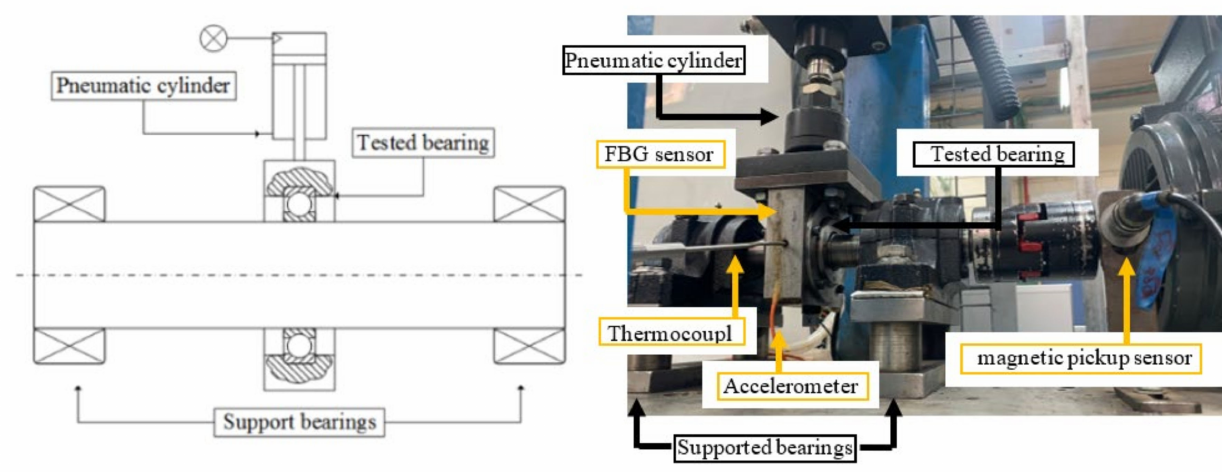
Figure 7. A schematic drawing and a picture of the test rig.